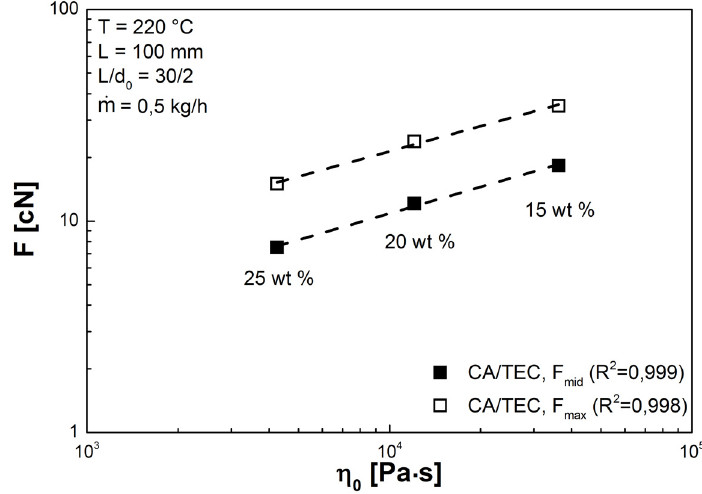
and mean drawdown force F max 0